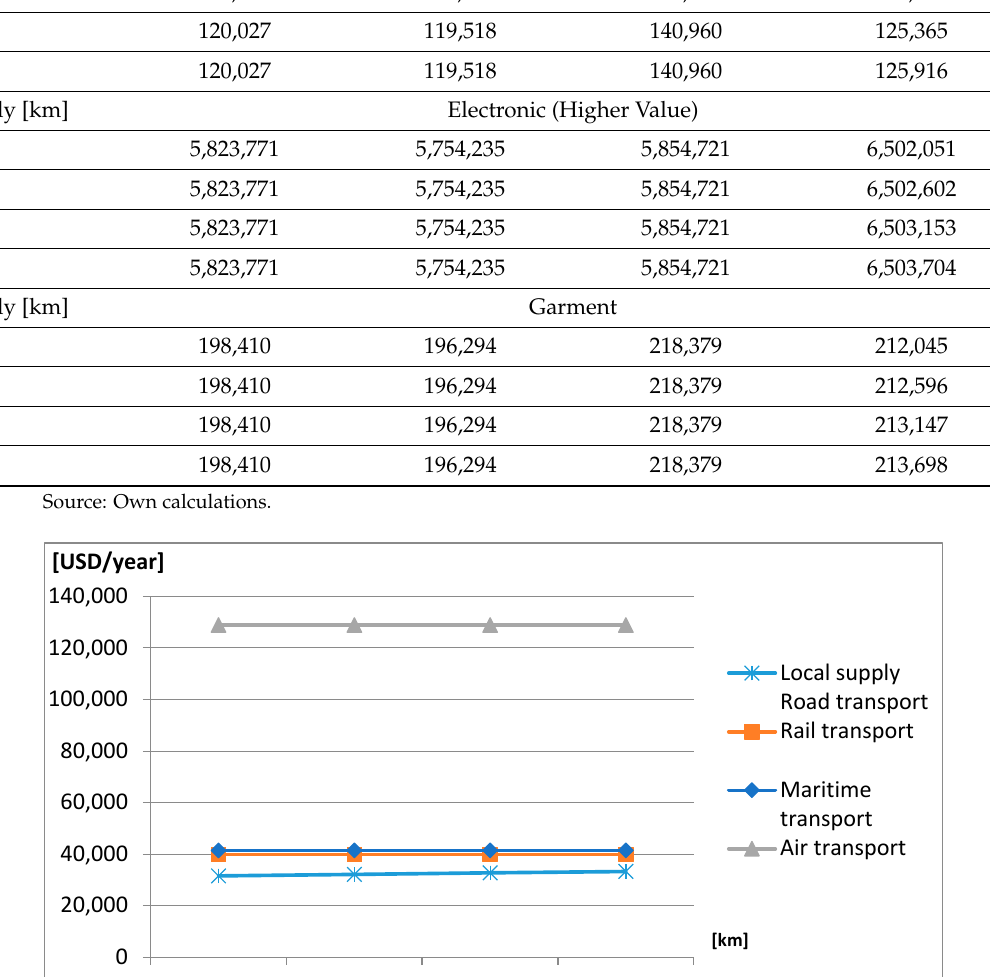
Table 3. Results of the simulations—impact of the increase of freight rates on total costs of deliveries and production [USD/year].